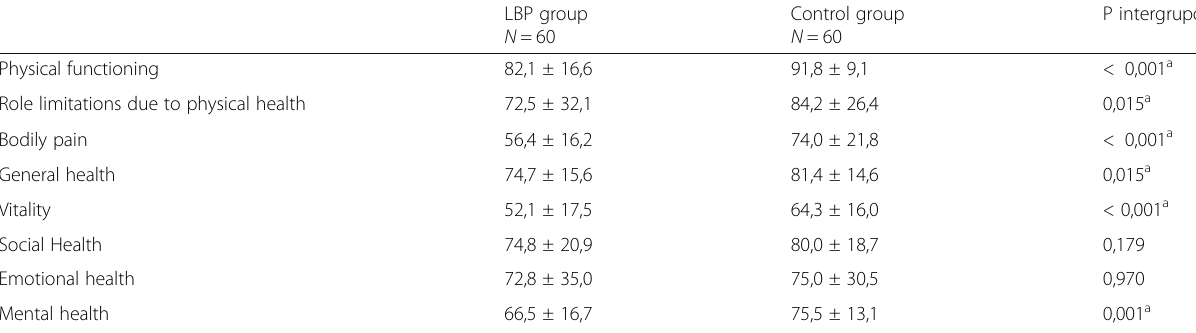
Table 4 Evaluation of the SF-36 demonstrated as mean and standard deviation